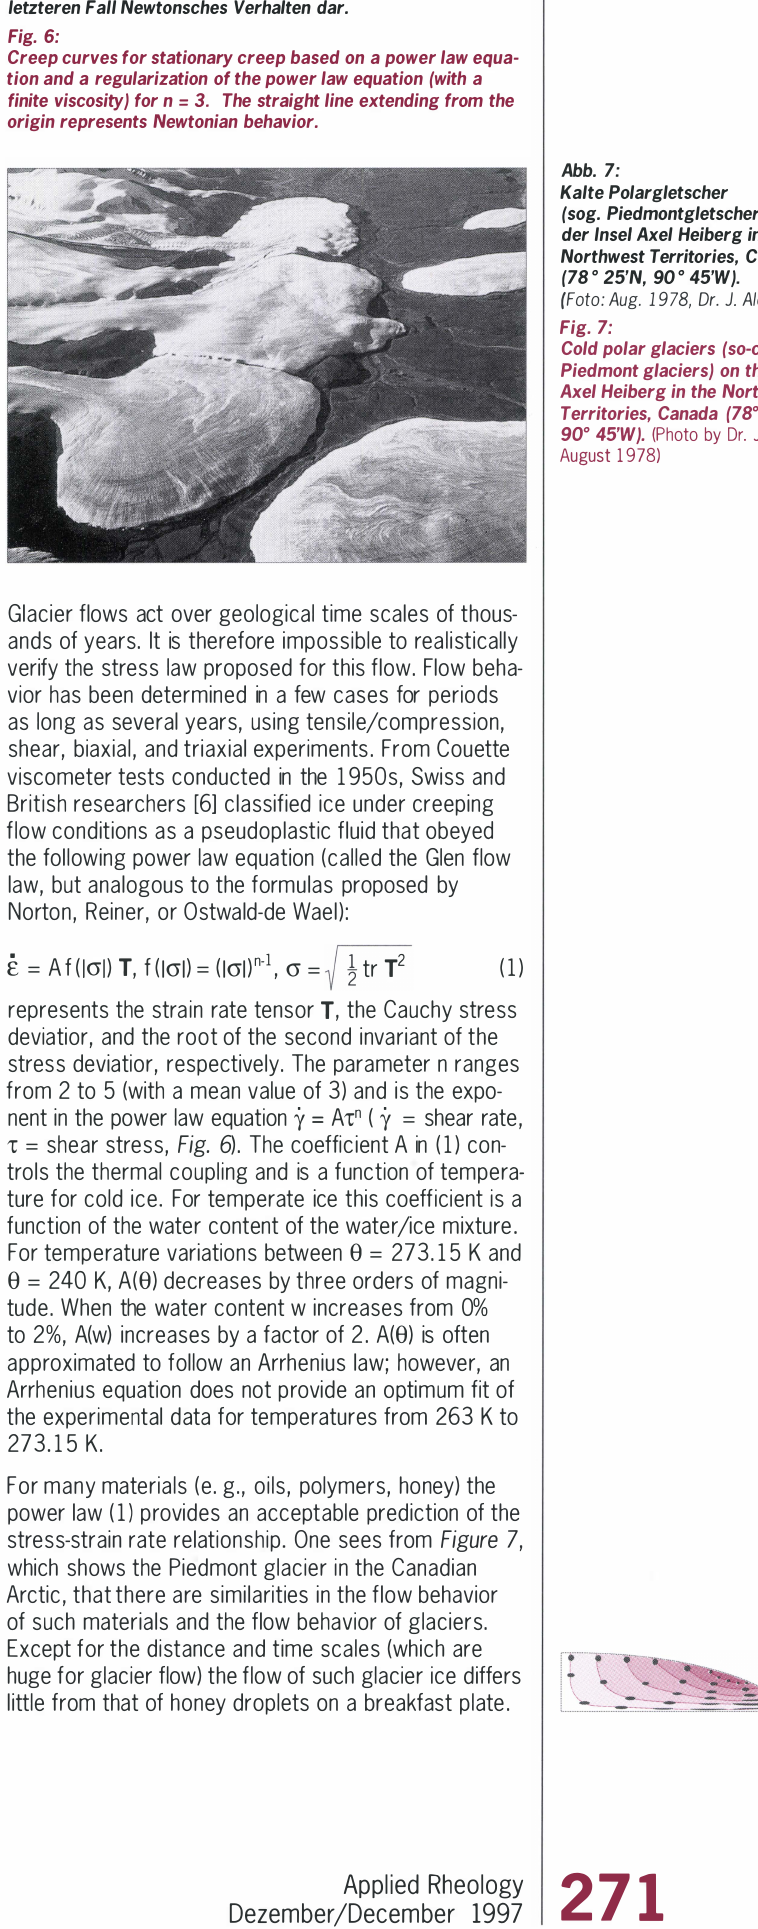
Fig. 6: Creep curves for stationary creep based on a power law equa­ tion and a regularization of the power law equation (with a finite viscosity) for n = 3. The straight line extending from the origin represents Newtonian behavior.